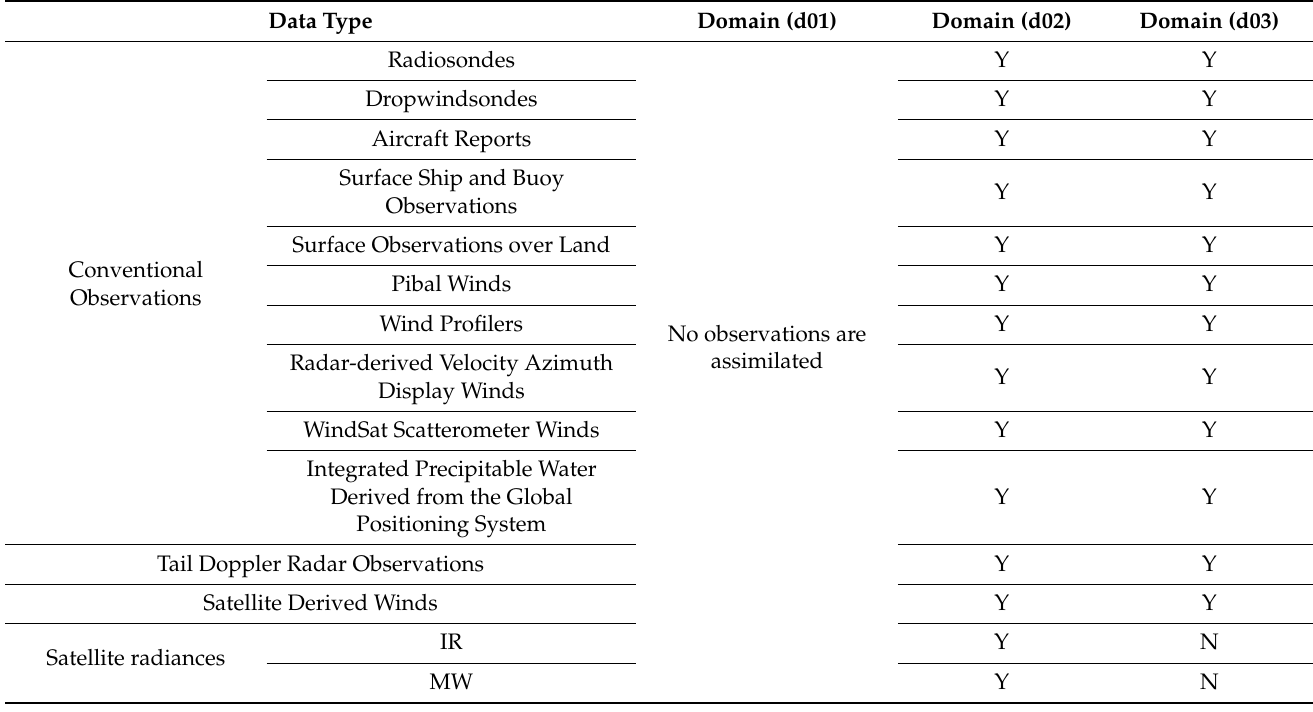
Table 1. Data types